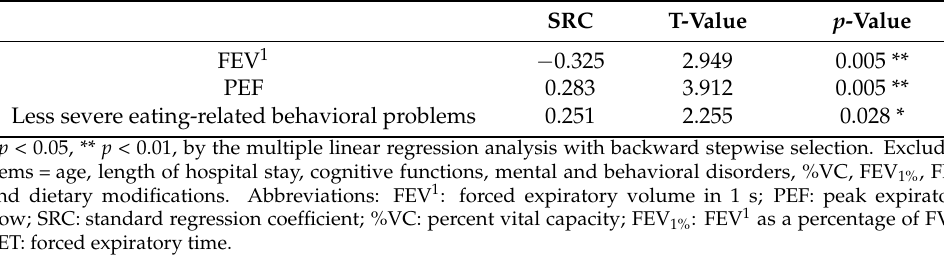
Table 2. Factors associated with the party-horn-integrated value. SRC T-Value p -Value FEV 1 − 0.325 2.949 0.005 ** PEF 0.283 3.912 0.005 ** Less severe eating-related behavioral problems 0.251 2.255 0.028